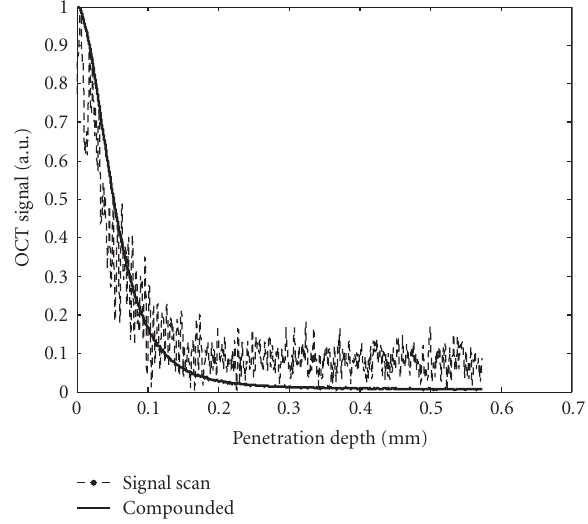
Figure 2: Single OCT depth-line scan (dotted line) compared to the compounded profile (continuous curve). The single-scan line is the 600th A-scan marked with a white interrupted line in Figure 1(b). The compounded profile results from the summation of 1000 consecutive